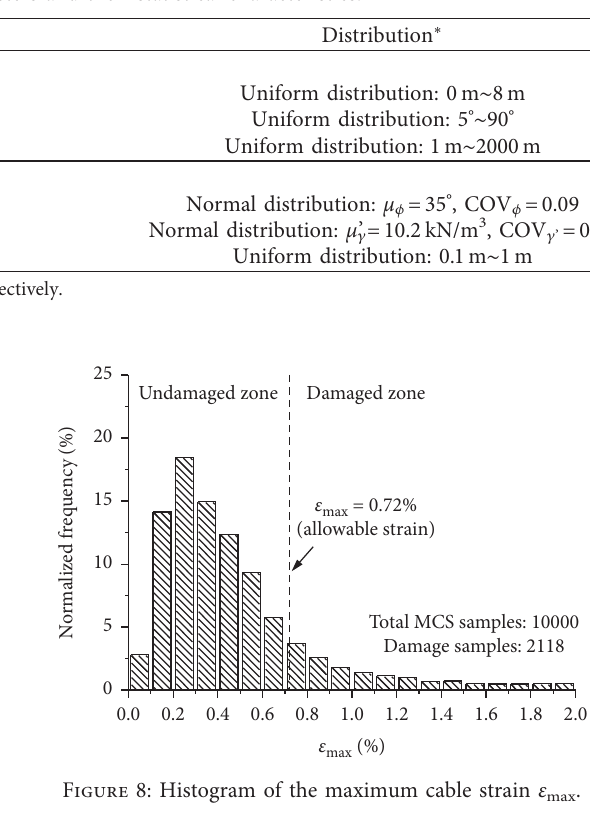
Table 1: Summary of uncertain parameters and their statistical characteristics.